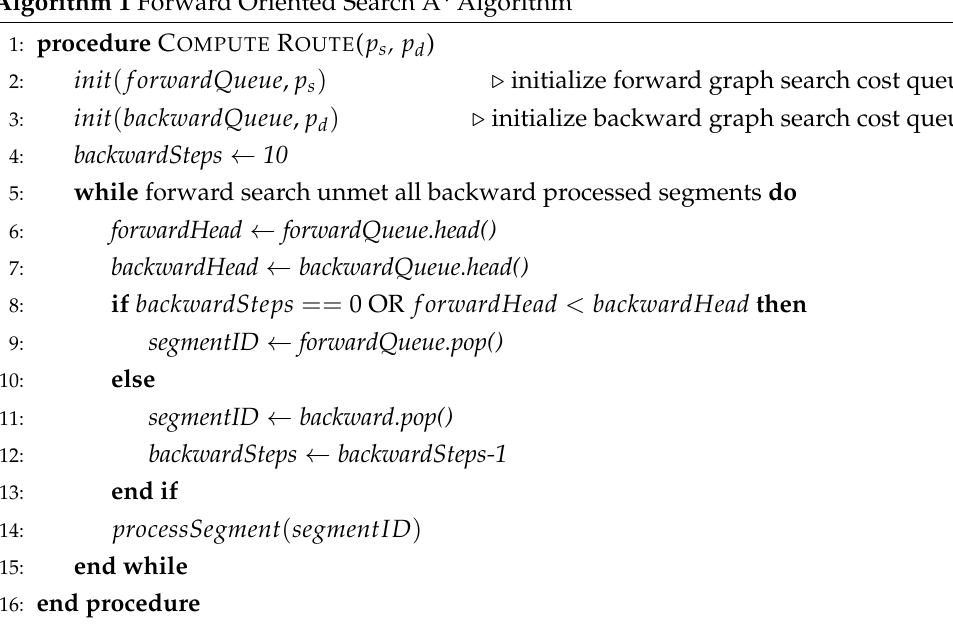
Algorithm 1 Forward Oriented Search A*